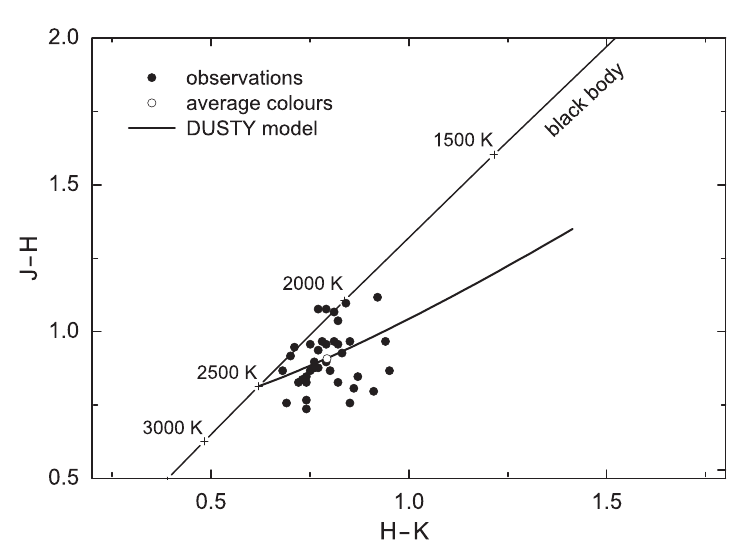
Fig. 2. Two-color JHK diagram of RR Tel used to determine long-term properties of the thin dust shell. The best (cid:12)t theoretical model and the blackbody line are shown. The model parameters are given in Table 1.